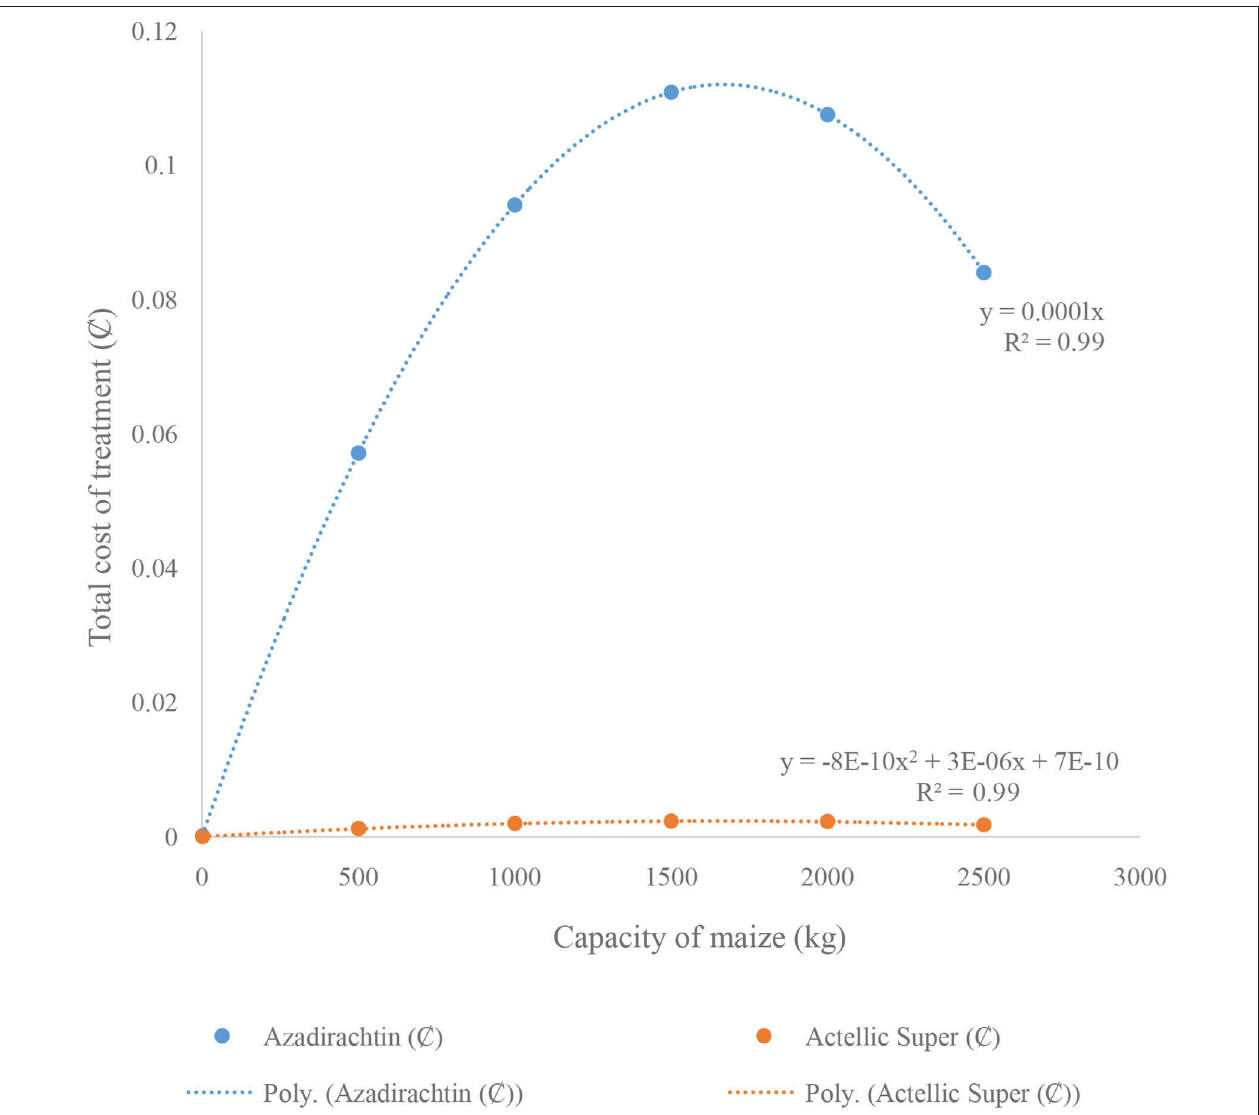
FIGURE 6 | Costs of treating 1, 500, 1,000, 1,500, 2,000, and 2,500kg capacities of maize grains by using azadirachtin and actellic super (generated using Microsoft